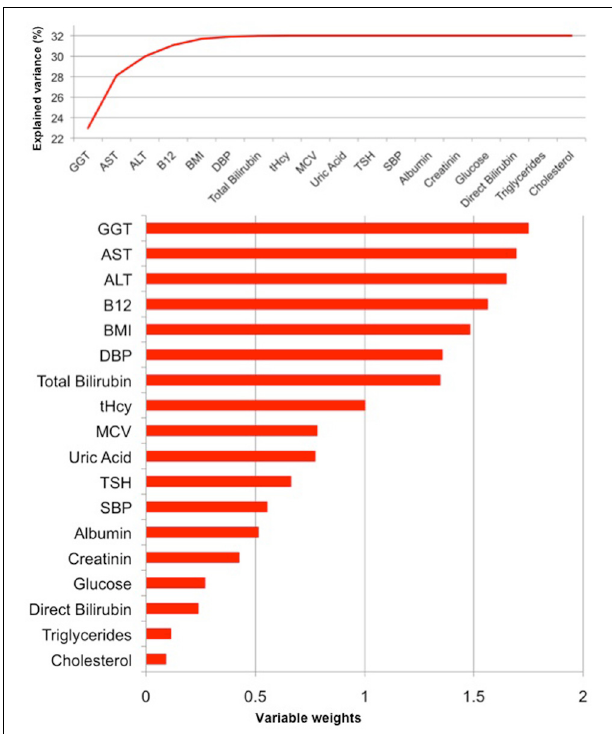
FIGURE 5 | PLS regression model of the female sample. When modeling the relationships between BrainAGE and health parameters, the PLS regression model explained 32% of variance in BrainAGE ( p < 0 . 01). GGT, AST, ALT, and vitamin B 12 are the most significant physiological and clinical chemistry parameters as they added most to the explained variance in BrainAGE (top chart) and also showed the highest variable weights, i.e., the highest impact in the regression model (bottom chart).